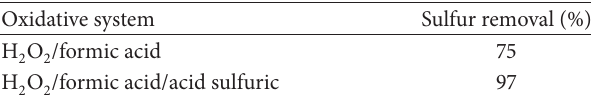
Table 2: The amount and levels of the variables in experimental